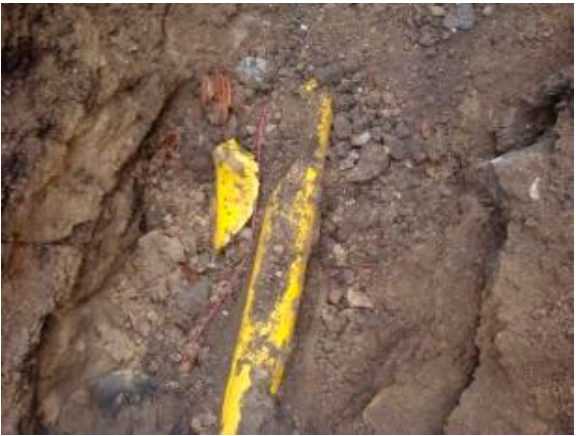
Figure 32. Defect in HDPE pipe.